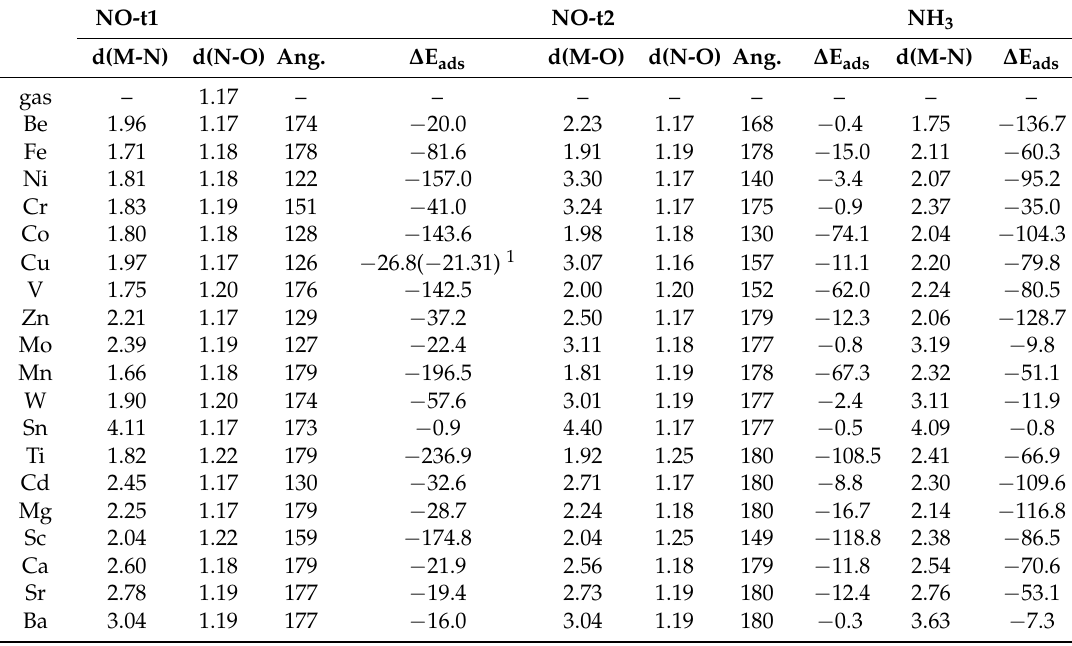
Table 1. Calculated distances between the metal center and the nitrogen d(M-N) (Å), N-O bond lengths within NO d(N-O) (Å), bond angles (Ang.) formed by the metal center of M-HKUST-1 and O and N in NO ( ◦ ) and adsorption energy ∆ E ads (kJ mol − 1 ) for molecular adsorption of NO and NH 3 on M-HKUST-1. NO-t1 NO-t2 NH 3 d(M-N) d(N-O)